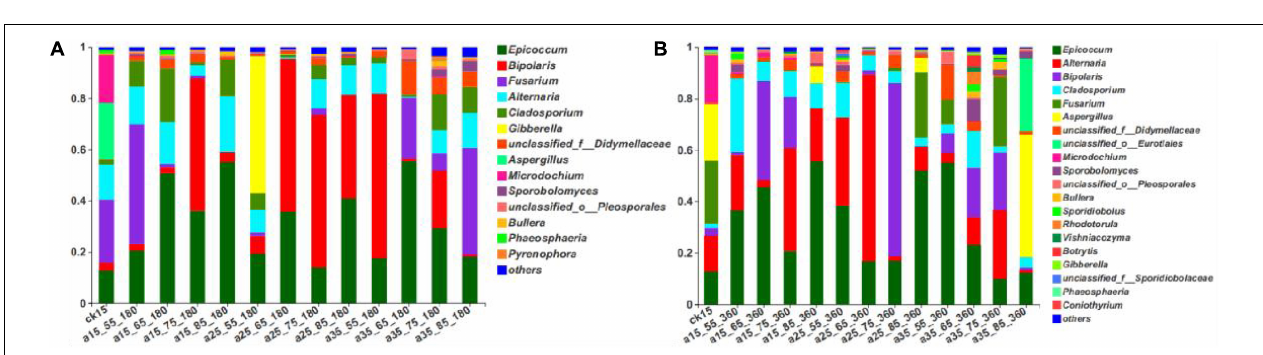
FIGURE 2 | The relative abundance of fungal community phyla levels in barley after storage for 180 days (A) vs. 360 days (B) . The relative abundance of each taxon was defined as the percentage of the same taxon relative to the corresponding total sequences for each sample. The species with relative abundance ratios < 1% were classified as “others.”